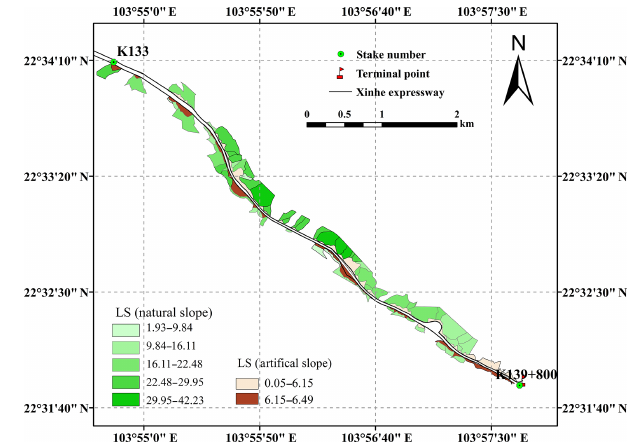
Table 3. Calculation results of the slope